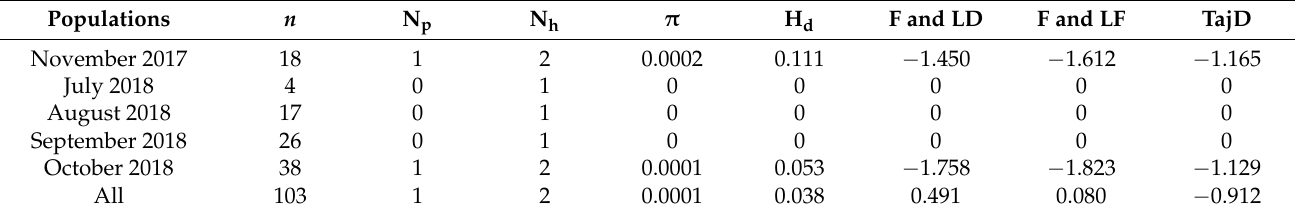
Table 4. Genetic diversity indices and neutrality test statistics per Kızkalesi temporal population. Sequence numbers ( n ), number of polymorphic sites (N p ), number of haplotypes (N h ), nucleotide diversity ( π ), haplotype diversity (H d ), Fu and Li’s D* (F and LD), Fu and Li’s F* (F and LF)